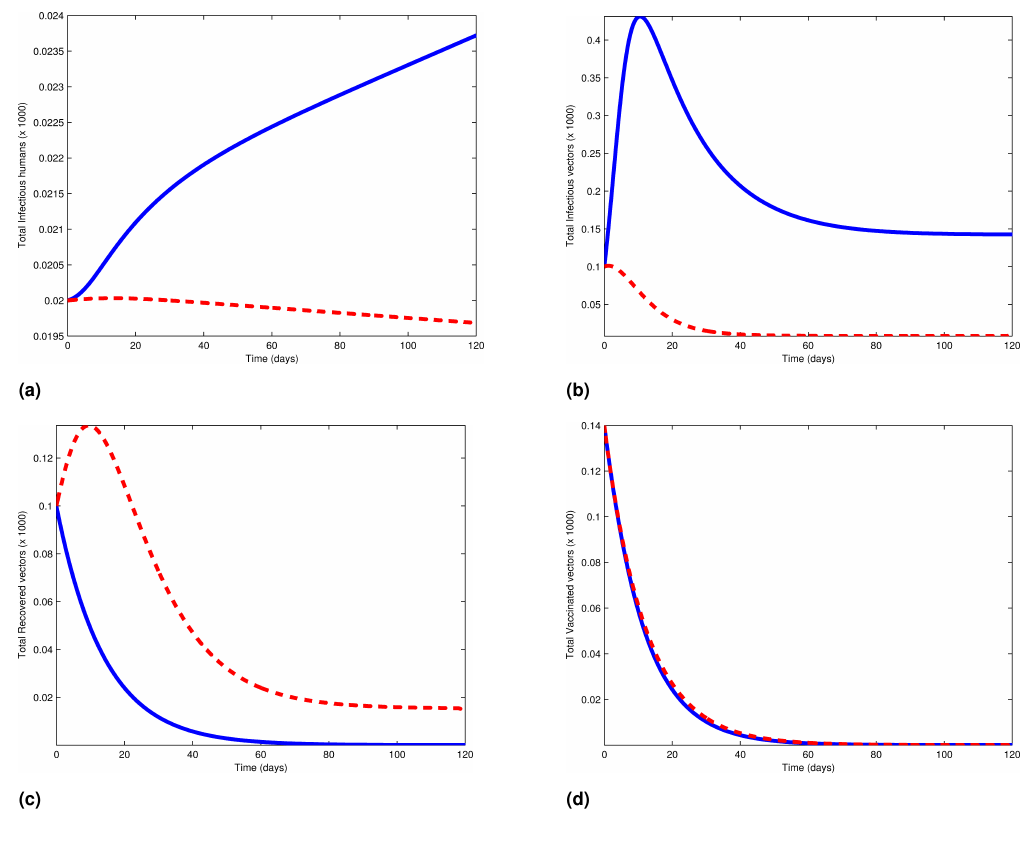
Fig. 5. Simulations of the leptospirosis model showing the effect of the optimal strategies: Prevention of humans and treatment of infectives vectors. The blue lines represent the cases without control, while the red lines indicate the cases with optimal